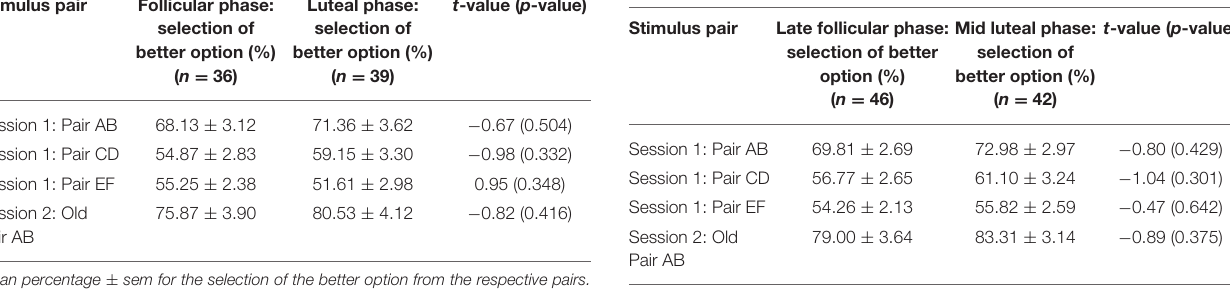
TABLE 3 | Learning performance did not differ between the late follicular and mid luteal phase in the meta-analysis based on the combined data from four independent